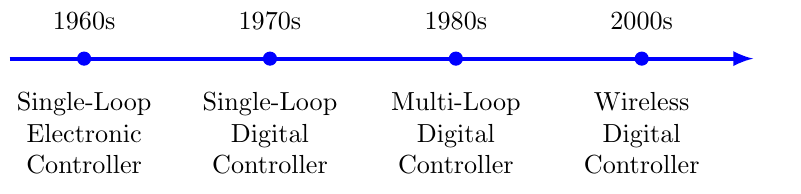
Figure 1. Evolution of wireless digital controllers.